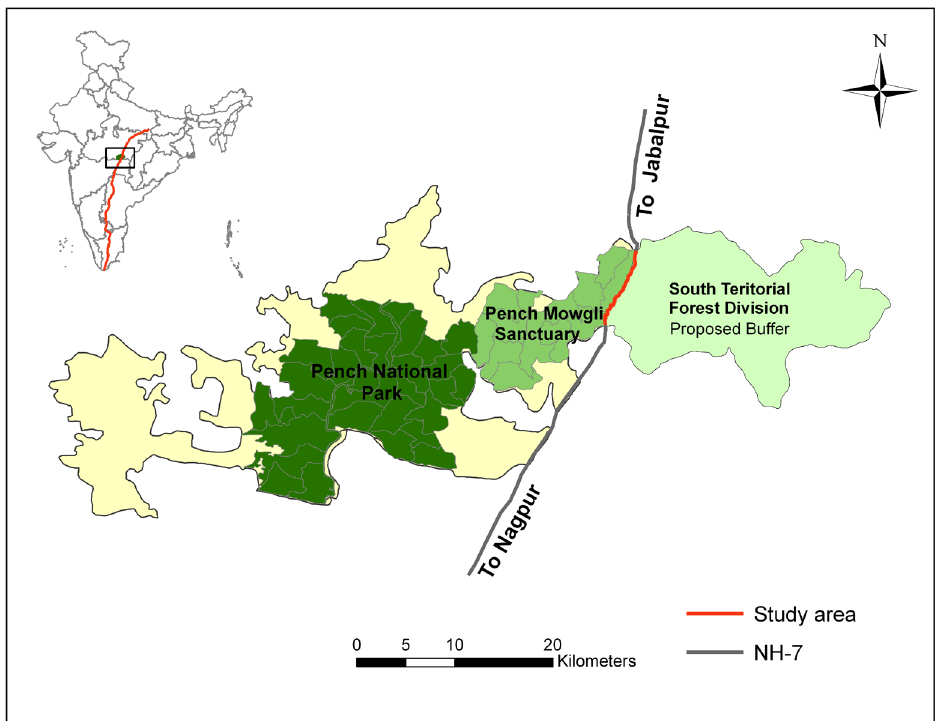
Figure 1. Section of the NH-7 representing the area of the